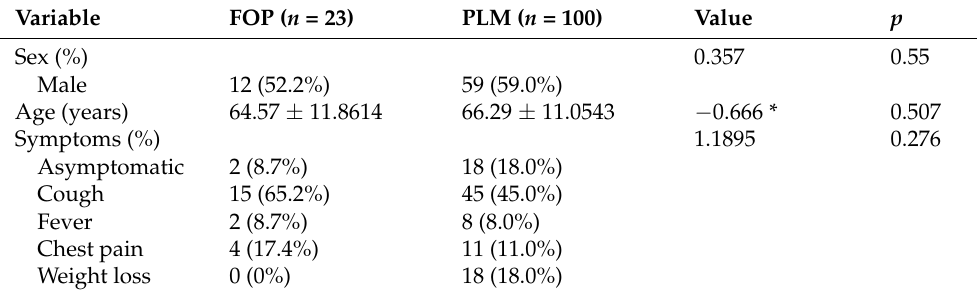
Table 1. Patient demographic and clinical